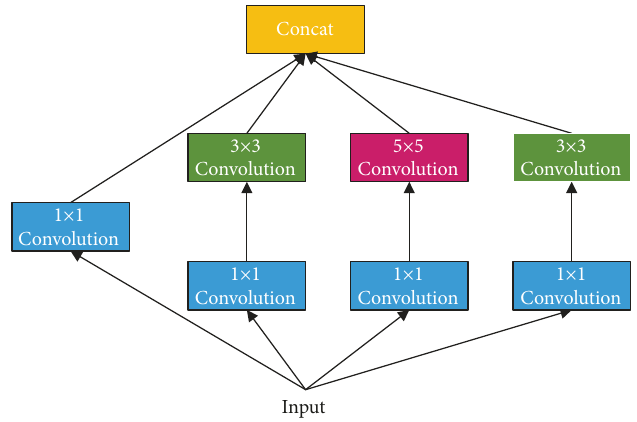
Figure 3: Inception module with 1 × 1 convolution.